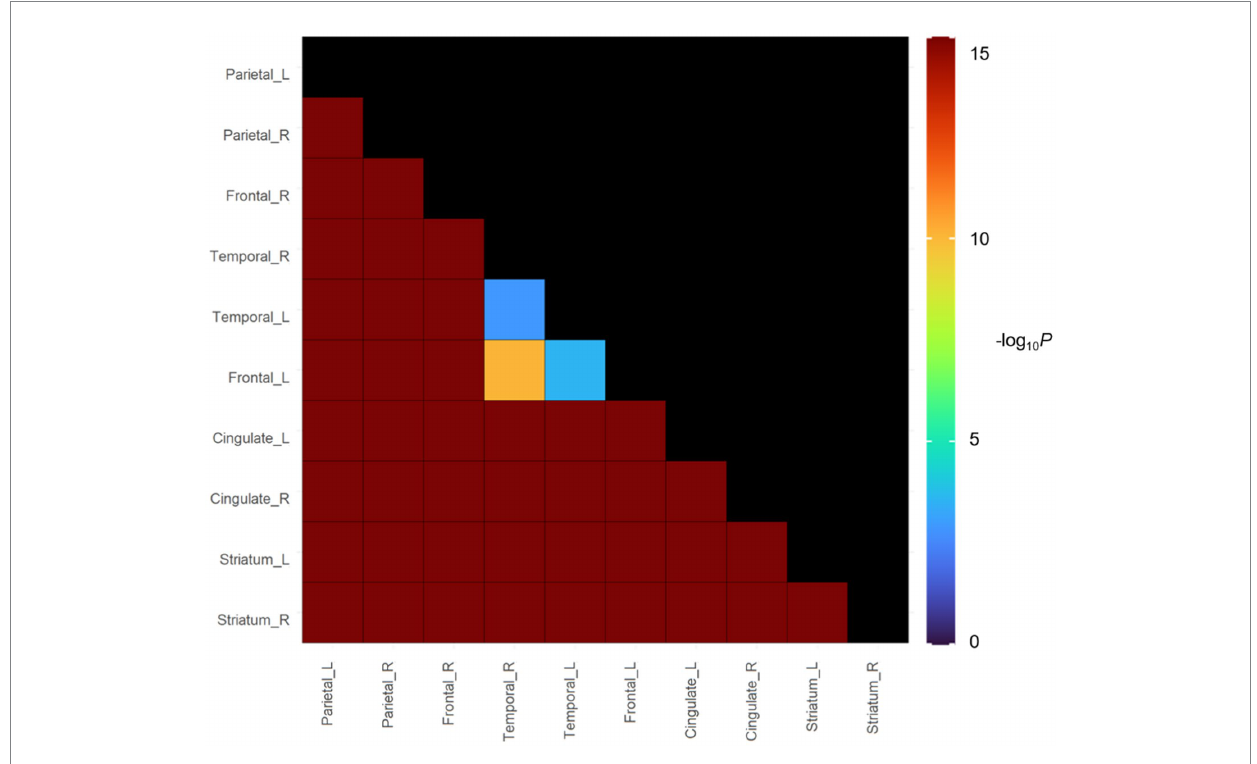
FIGURE 4 In vivo Spreading Order of focal amyloid PET group in cognitive continuum. Color bars represent logarithmic scale of p value ( − log 10